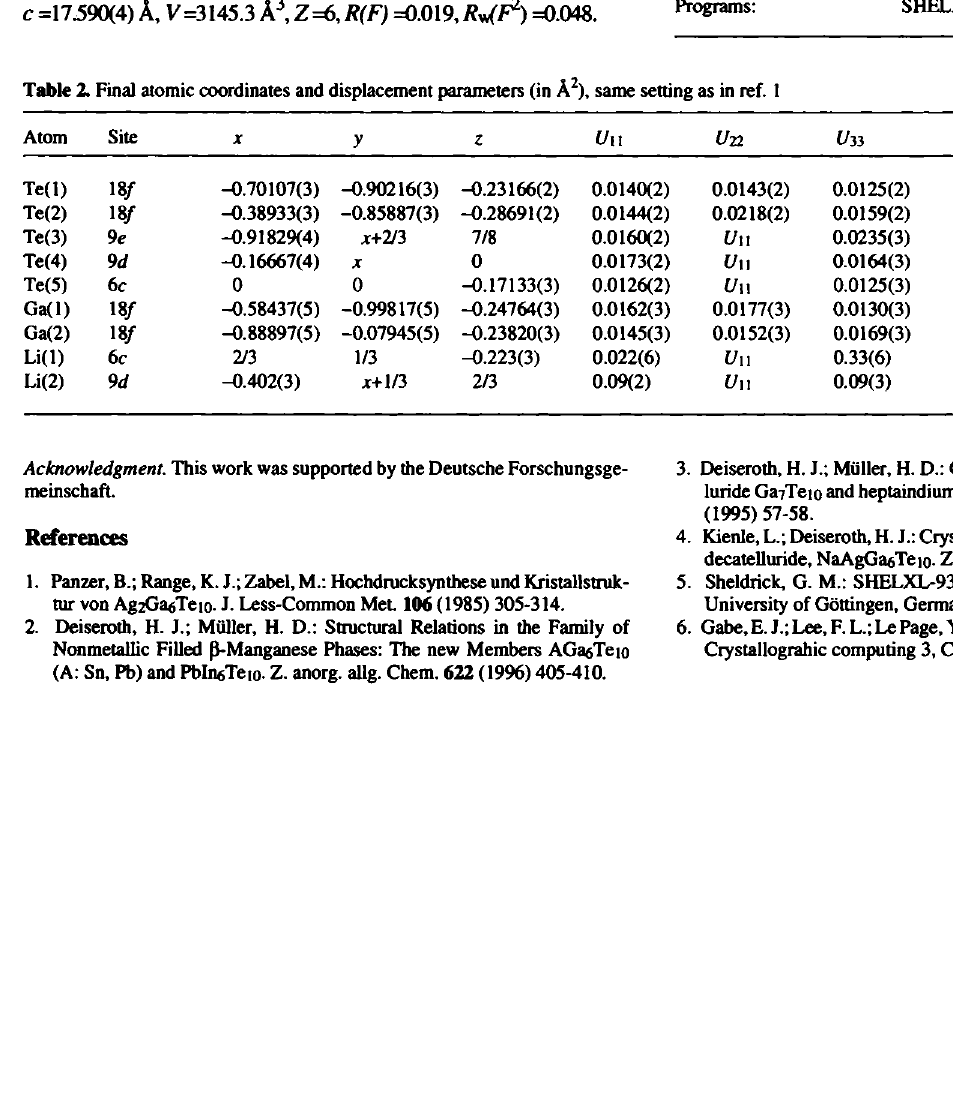
Table 2. Final atomic coordinates and displacement paraineteis (in Â^), same setting as in ref.